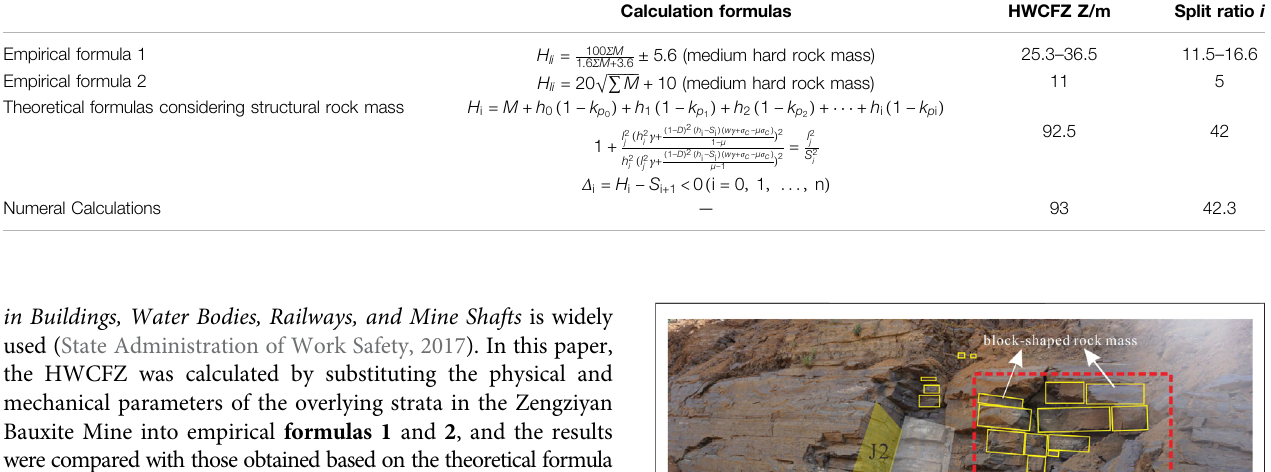
Calculation formulas